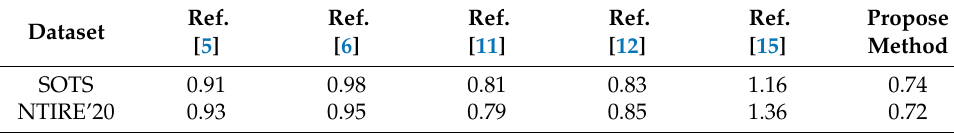
Table 3. The running time of the experimental algorithm.